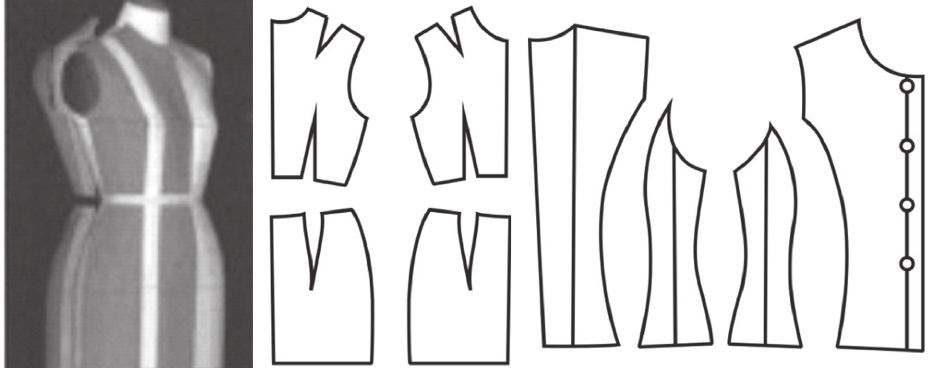
Figure 10: Transformation of a 3D garment into 2D prototypes in a virtual environment.